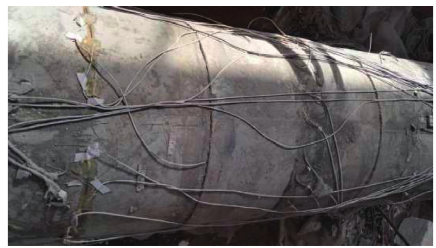
Figure 12: External view of the oval tunnel opening.